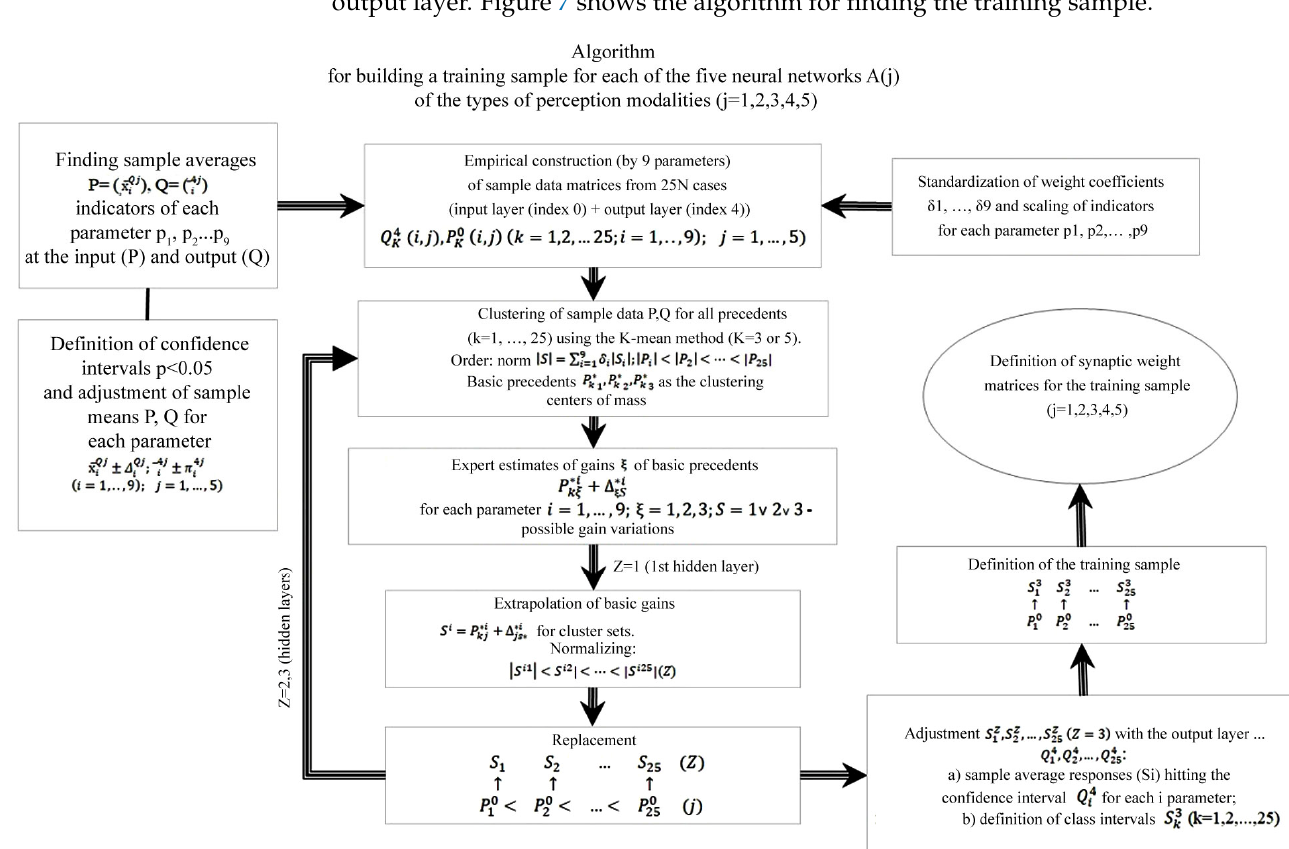
Figure 7. Training sample algorithm for the hybrid neural network.